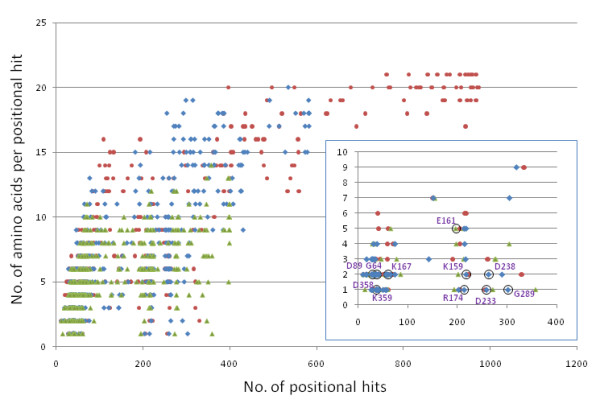
Amino-acid variability (y-axis) versus number of positional hits (x-axis) for three window sizes. Red circles: window size 70; blue diamonds: 80; green triangles: 90. Inset: positional hits at which the dominant residue occurs at frequency > = 80%. Circles: positional hit, variability coordinate pairs corresponding to the 11 positions shown in Fig. 5.